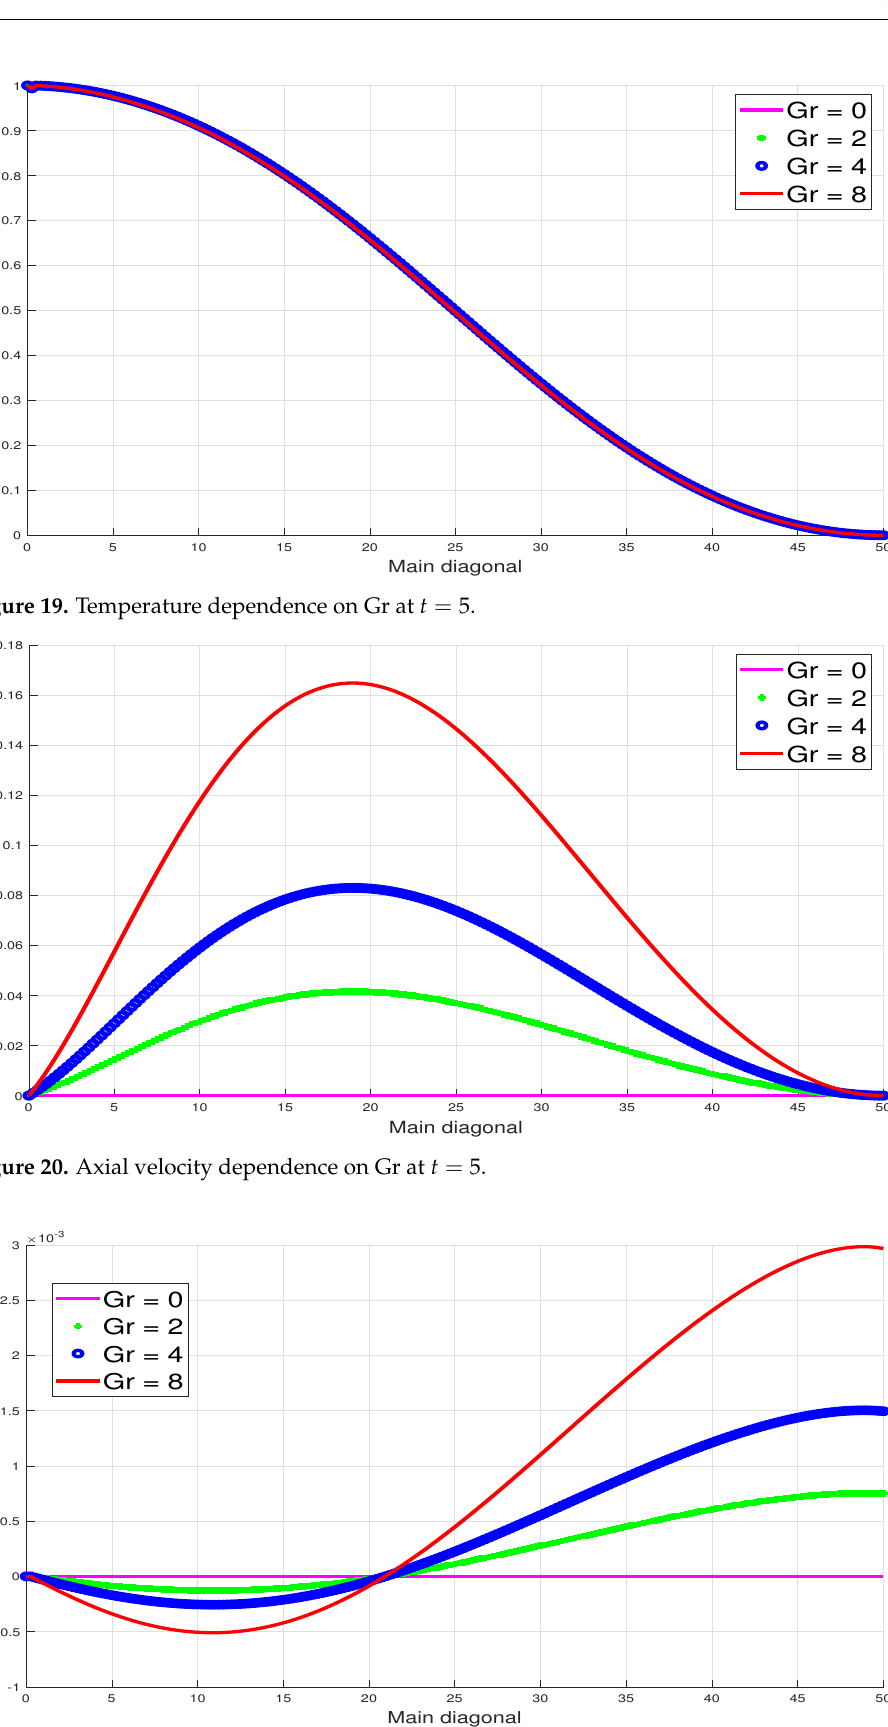
Figure 21. Transverse velocity dependence on Gr at t =